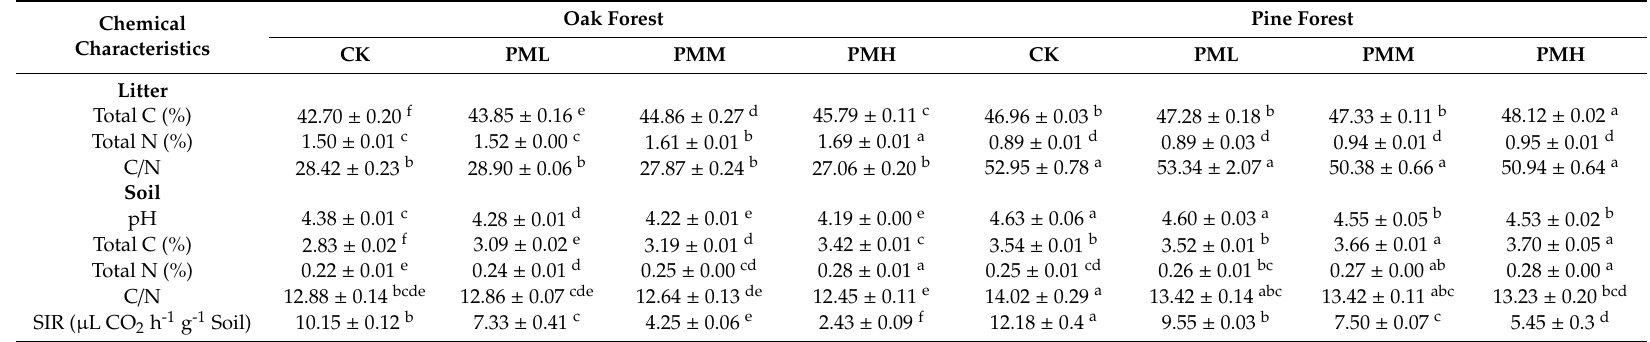
Table 3. The chemical characteristics (means ± SD, n = 4) of the litters and soils used for the leaf litter decomposition experiment after six months of decomposition. Chemical